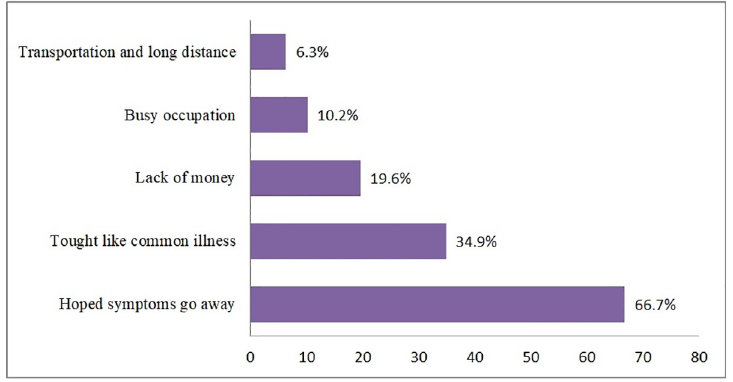
Fig 1. Perceived reasons for delay health care seeking among TB patients in Gamo zone public health facilities, Southern Ethiopia, 2019.